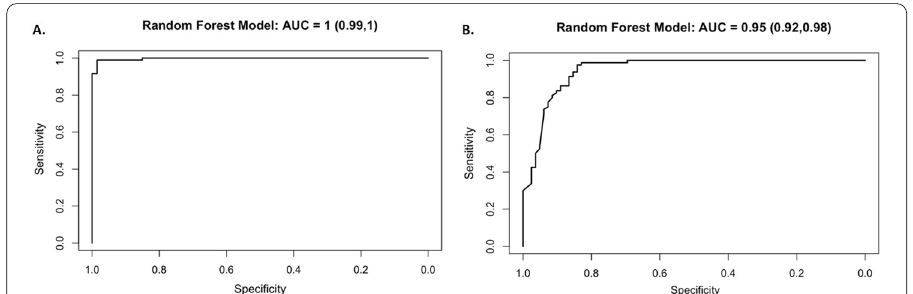
Fig. 6 Random forest classification models describing the accuracy of statistical predictions given a discrimination threshold of a 0.9 or b